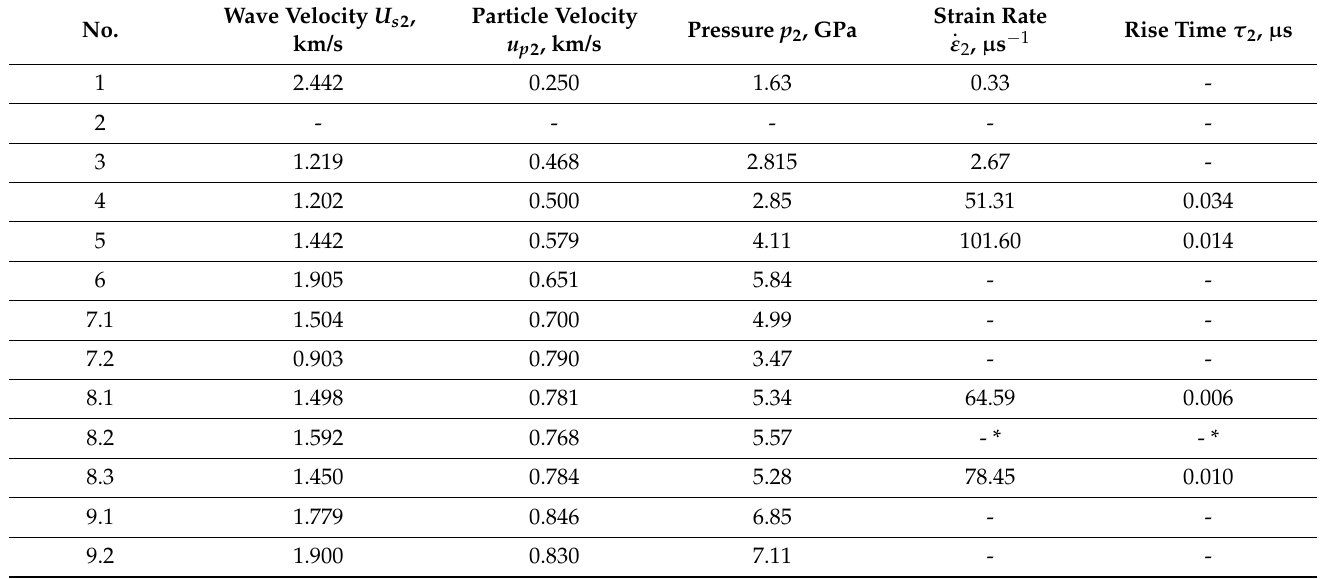
Table 3. Hugoniot and wave front data for compaction